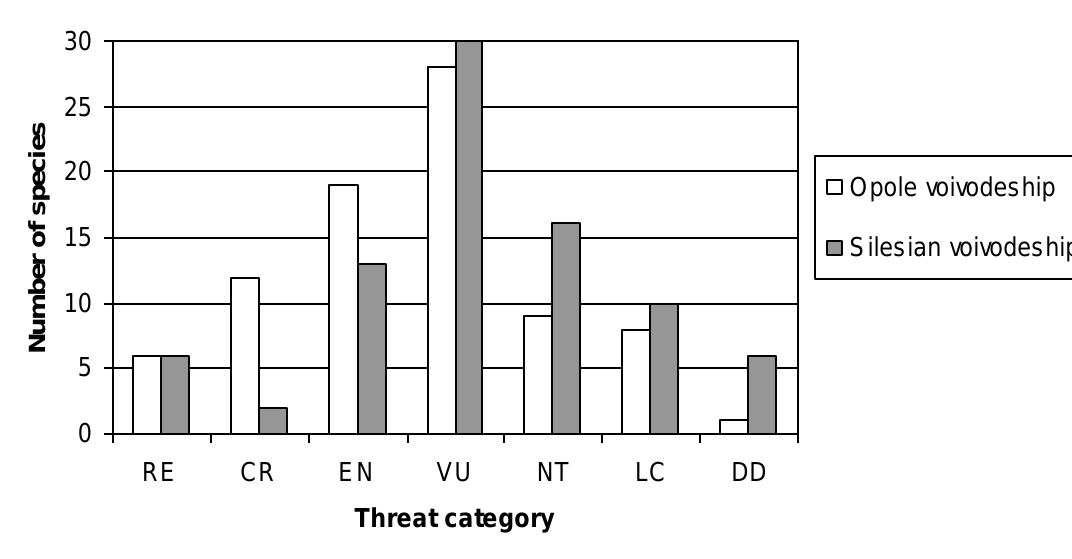
Fig. 4. Comparison between number of species recorded in Strzelce Opolskie from red lists of vascular plants of Opole and Silesian voivodeships (see abbreviations key for Table